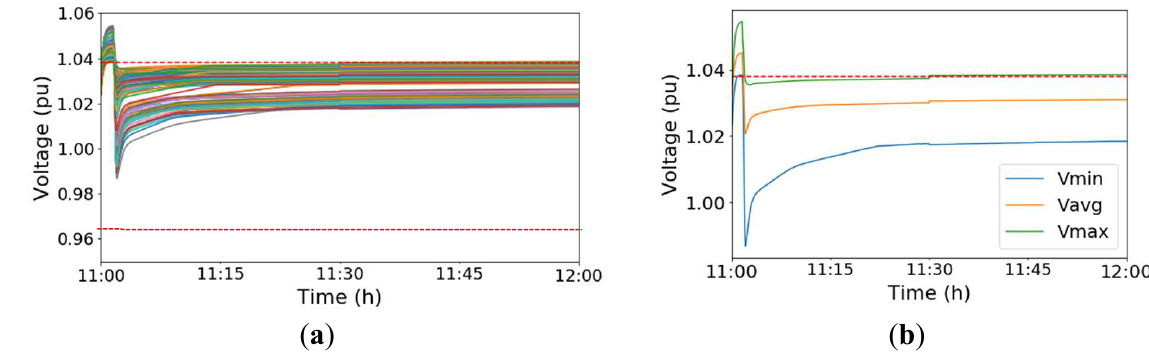
Figure 15. Voltage measurements of the scenario with DERMS control: ( a ) all the voltages across the feeder and ( b ) the average, maximal, and minimal voltages.